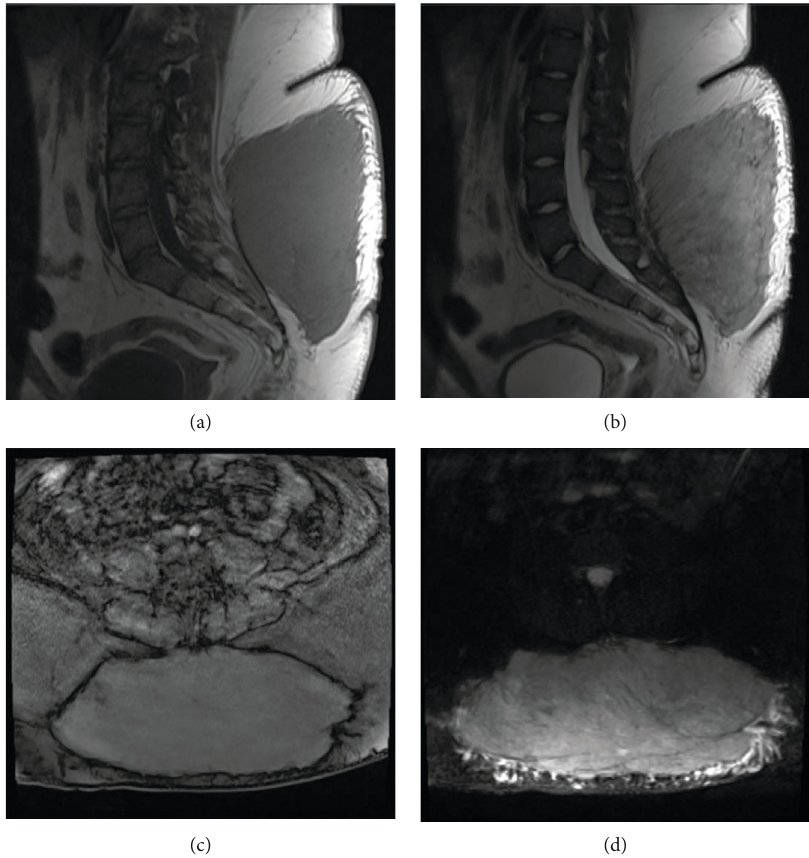
Figure 1: Representative preoperative 1.5 Tesla MRI images. (a) T1 TSE sagittal (TR 625ms, TE 13 ms). (b) T2 TSE sagittal (TR 4160ms, TE 97ms). (c) T1 VIBE FS axial (TR 5.07, TE 2.39 ms). (d) T2 TSE FS axial (TR 5080 ms, TE 81 ms). These images revealed a large mass in the subcutaneous tissues of the lower back. The mass measured 24.8 cm × 10.4cm × 20.5cm in transverse, anteroposterior, and caudocranial dimensions. It extended in close proximity to the super fi cial fascial plane over the paraspinal musculature. No de fi nite muscular involvement was identi fi ed. The lesion demonstrated high signal on the T2-weighted sequences and intermediate signal on the T1- weighted sequences. TSE = turbo spin echo, FS = fat suppression, VIBE = volumetric interpolated breath-hold examination, TR = repetition time, and TE = echo